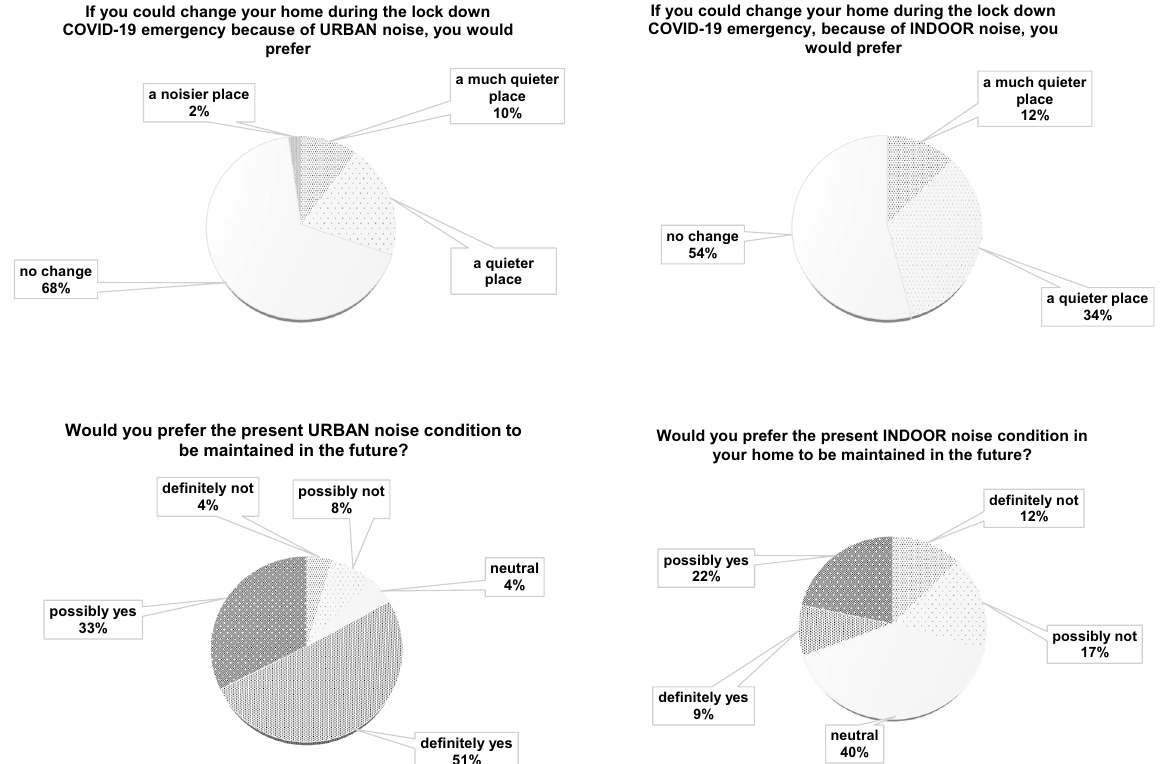
Figure 12. International results: comparison between urban and home variation future preferences.